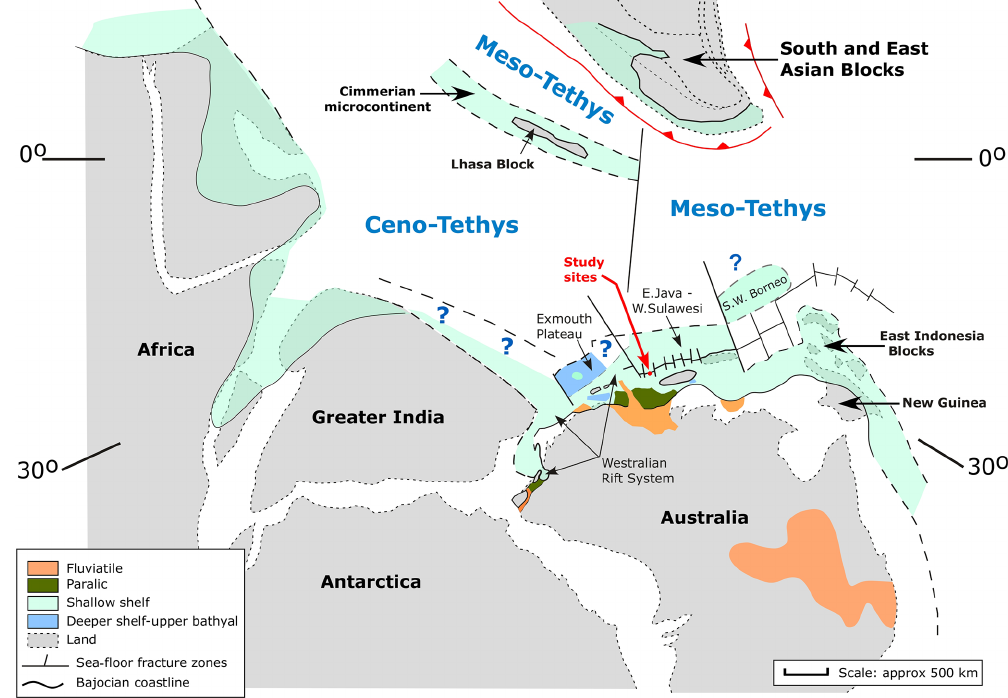
Figure 1. Palaeogeographic reconstruction of the southern shoreline of the Tethys in the early Bajocian (based on data in Metcalfe, 2013; Bradshaw and Yeung, 1992; Apthorpe, 1994; Powell et al., 1980; Exon and Colwell, 1994; Johnson et al., 1976; and Veevers and Cotterill, 1978). Study sites are shown at the arrowed red